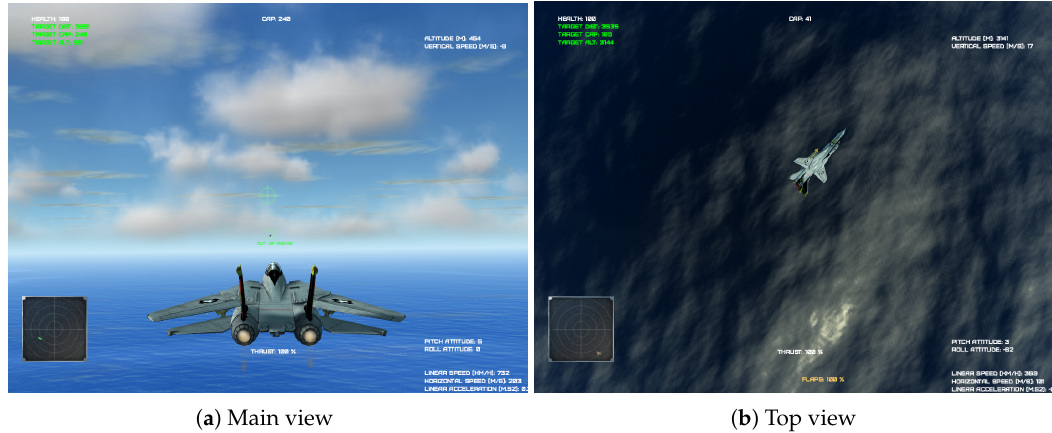
Figure 4. The graph user interface of the aerial combat simulation platform.